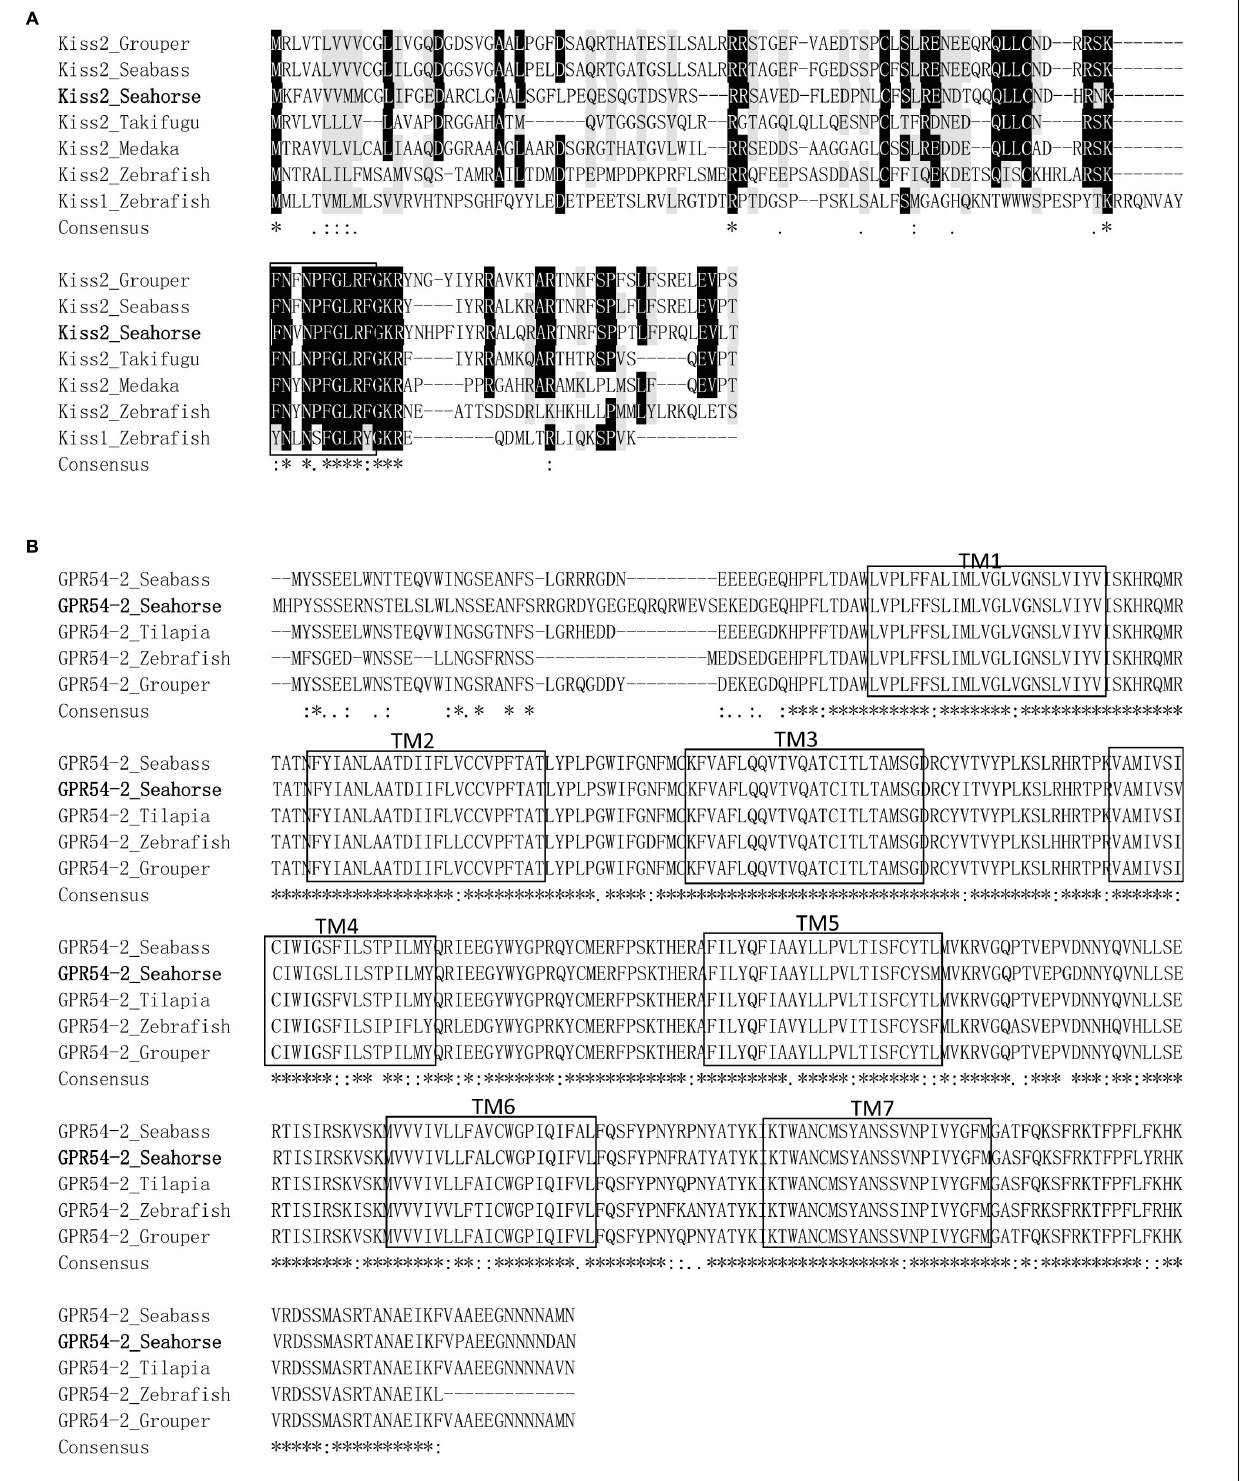
Frontiers in Neuroscience |